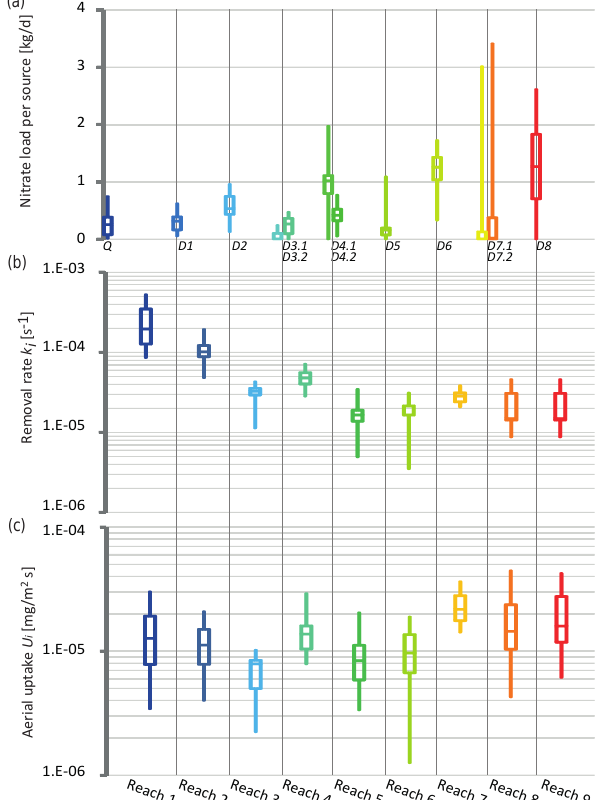
Figure 6. (a) Hierarchy and range of nitrate loads per source ranked by their median nitrate load emission. (b) Hierarchy and range of in-stream nitrate removal rates k i per reach sorted from upstream to downstream. (c) Range of areal uptake rates U i per reach sorted from upstream to downstream. Boxplots present the 0.01, 0.25, 0.5, 0.75 and 0.99 quantiles of each